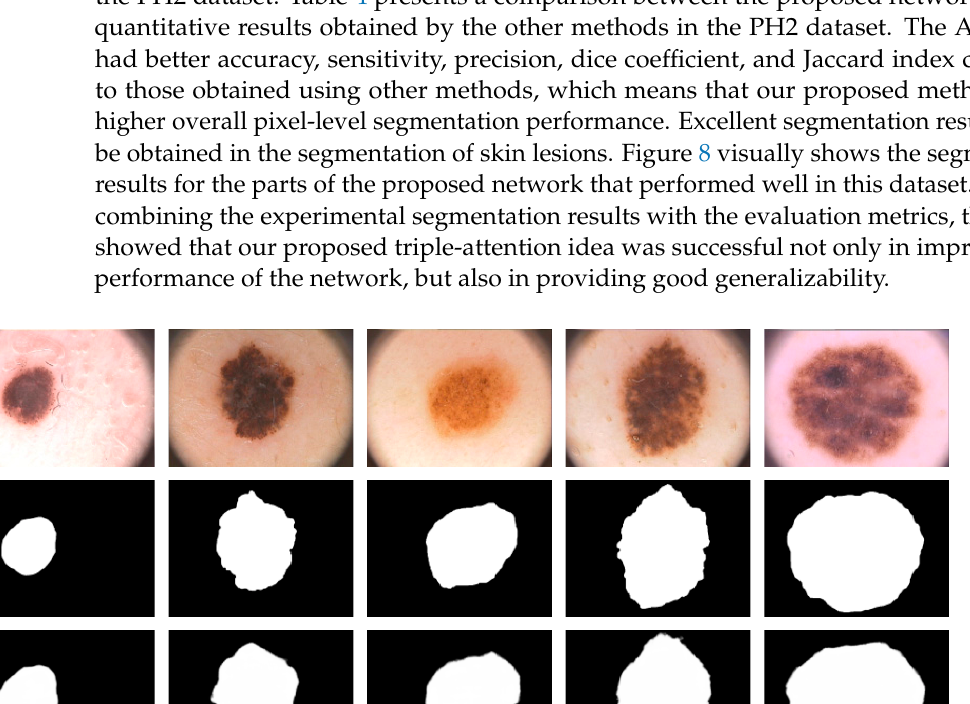
Figure 8. Segmentation results of ASCU-Net on the PH2 dataset. The first row is the original image. The second row is the skin lesion segmentation ground truth (GT). The third row is the visual segmentation result of the test set of the proposed network.